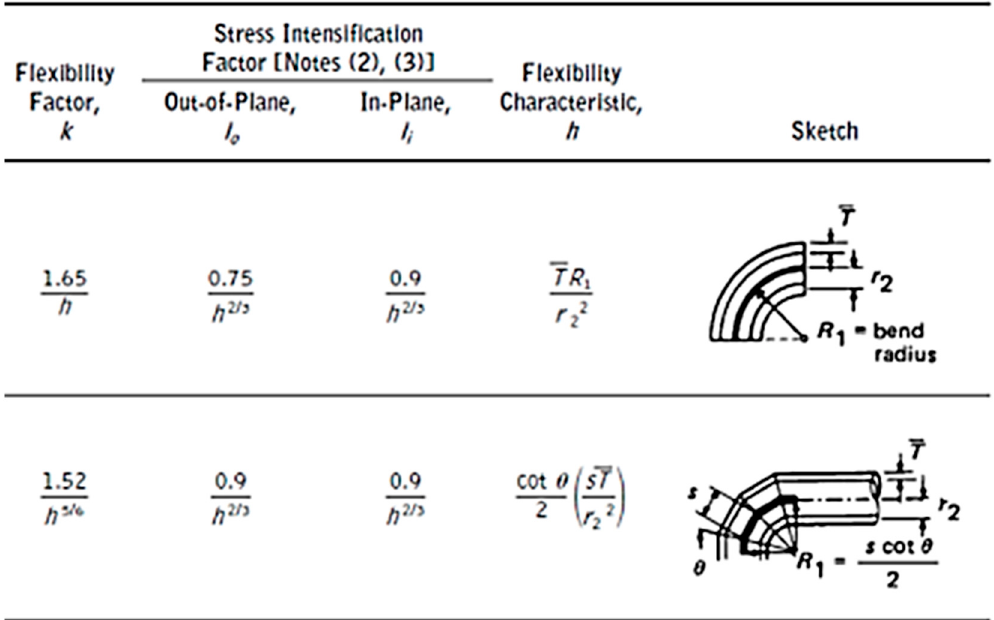
Figure 2. Flexibility factor and stress intensification factor (ASME, 2014) [3].